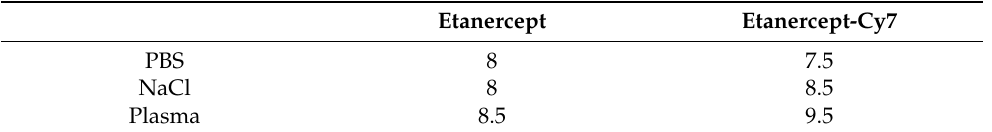
Figure A1. Absorption spectra of ELISA reagents, Enbrel and Enbrel with Cy7. Table A1. pH of the different solutions in the presence of microcapsules which contained etanercept and etanercept-Cy7.